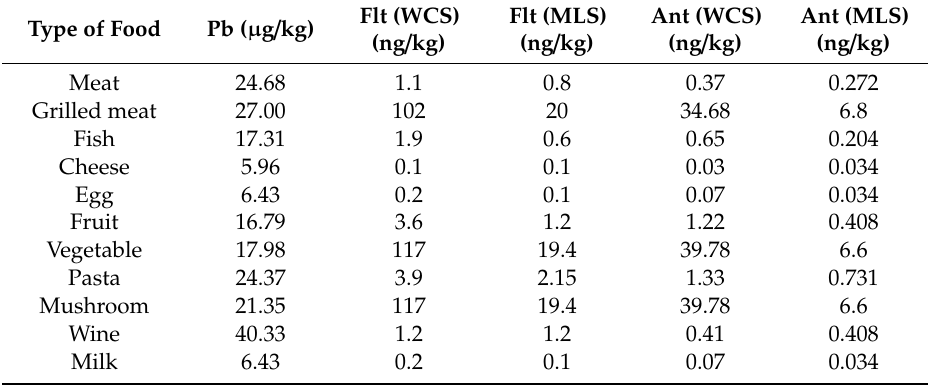
Table 5. Contaminant concentrations in food in the worst case scenario (WCS) and in the most likely scenario